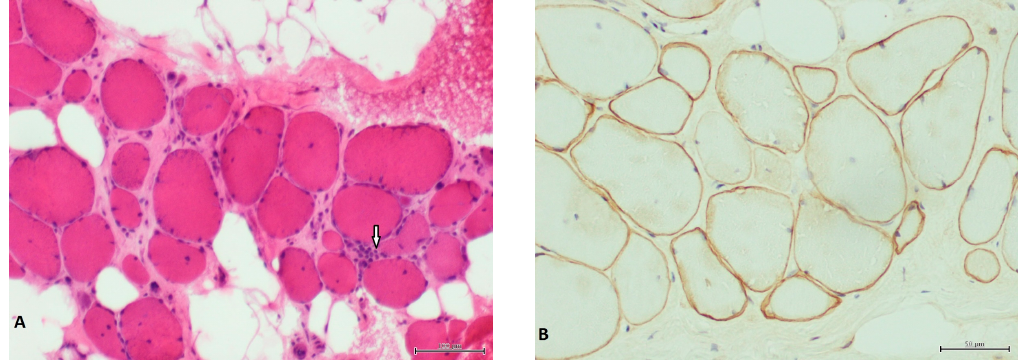
Figure 1. Patient’s muscle biopsy. ( A ) Hematoxylin and eosin stain showing severe fibrosis and fat substitution. Arrow indicates a necrotic fiber. Scale bar corresponds to 100 µm. ( B ) Dys2 antibody showing irregular and faint staining of dystrophin. Scale bar corresponds to 50 µm.